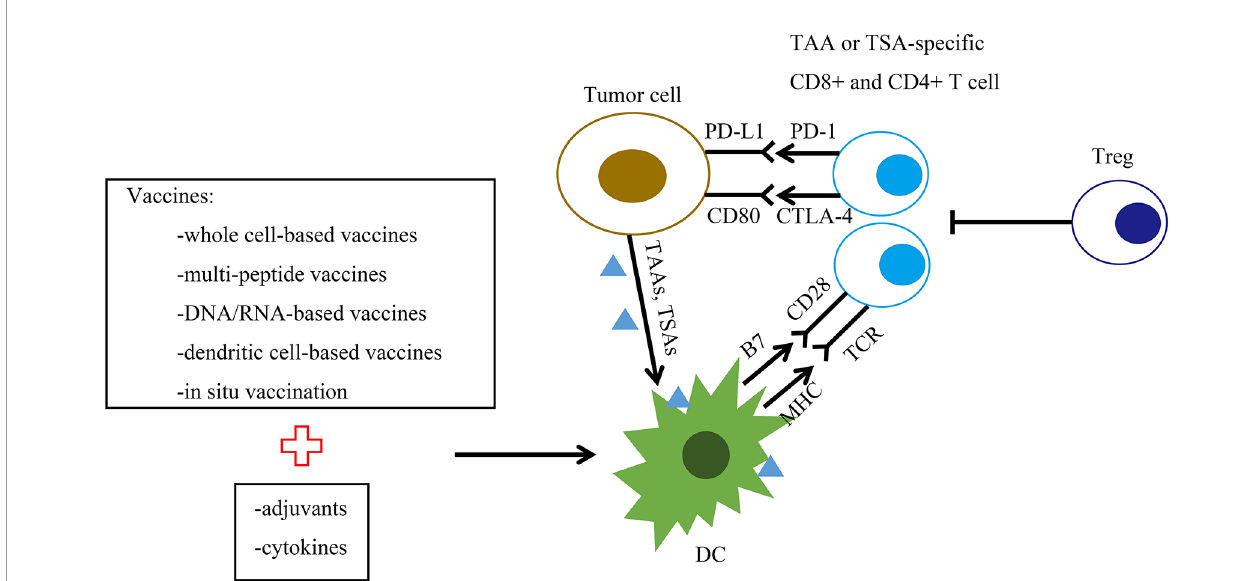
FIGURE 1 | Graphic representation of the therapeutic breast cancer vaccine platforms and their mechanism of action. The fi gure summarizes the spectrum of vaccine targets and vaccine platforms for breast cancer. Vaccine platforms are whole cell-based vaccines, multipeptide vaccines, DNA/RNA-based vaccines, dendritic cell (DC)-based vaccines and in situ vaccination. DCs present processed tumor-associated antigen (TAA) or tumor-speci fi c antigen (TSA) to CD4+ and CD8+ T cells. This interaction generates TAA/TSA-speci fi c effector T cells, leading to the killing of tumor cells. B7, B7 protein; CD28, T cell costimulatory molecule CD28; CTLA-4, cytotoxic T lymphocyte-associated antigen 4; DC, dendritic cell; MHC, major histocompatibility complex; PD-1, programmed cell death protein 1; PDL-1, programmed death ligand 1; TAAs, tumor-associated antigens; TSAs, tumor-speci fi c antigens; TCR, T cell receptor; Treg, regulatory T